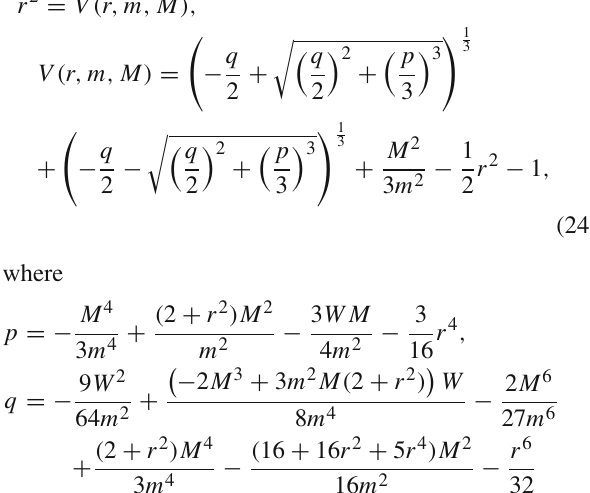
requires turning points to be located within the interval sat- isfying f + ≥ 0, since f + < 0 in r − < r < r + , there are no turning points for thin shells in this interval. Supposing the locate at 0 < r 1 < r − and r 2 > r + respectively, we